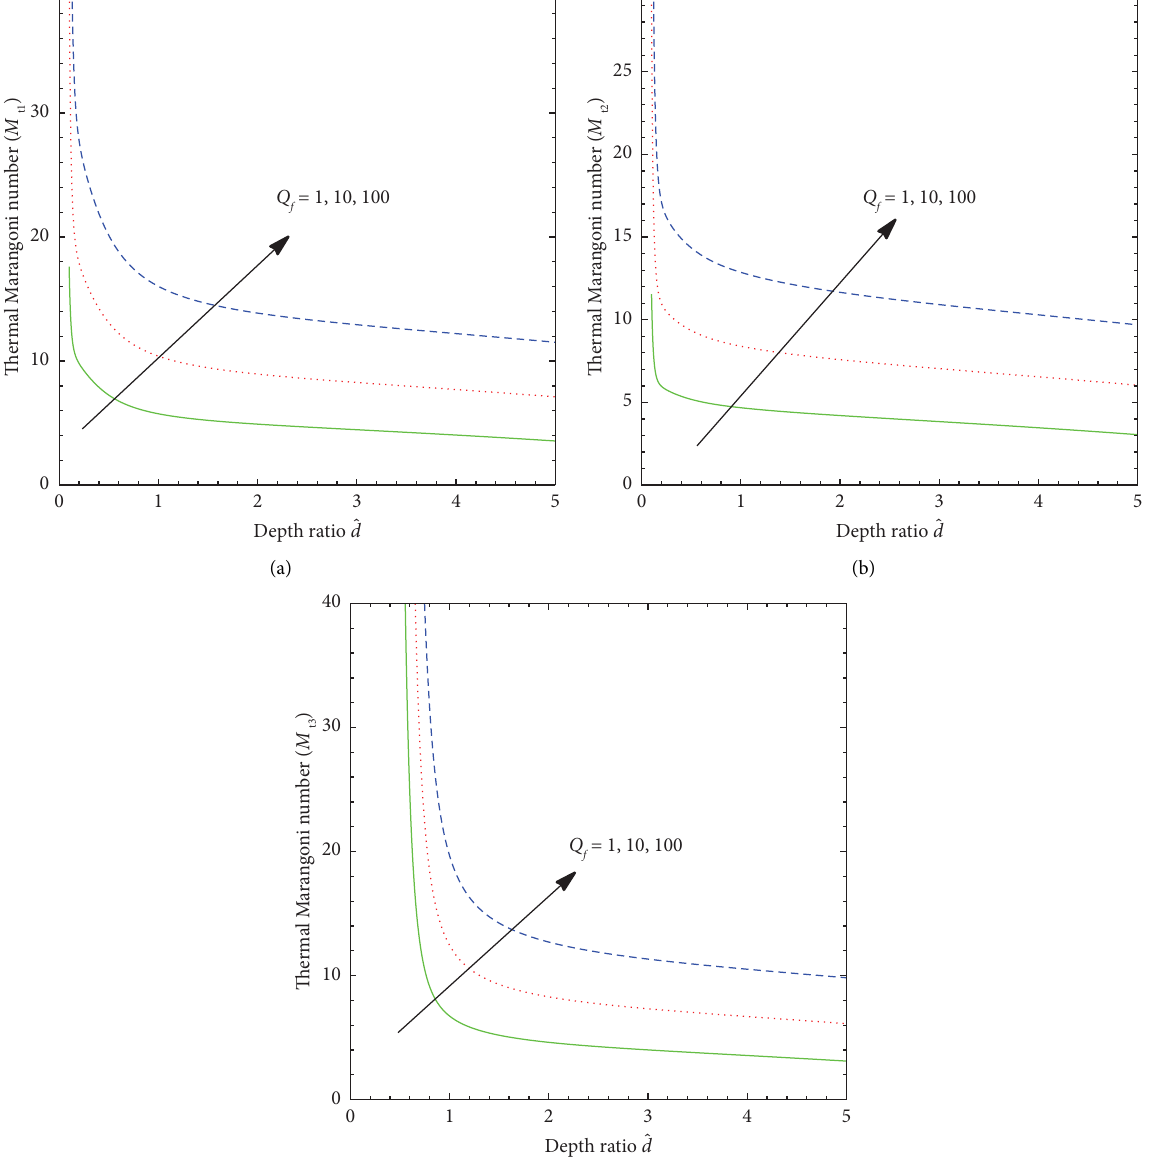
� 1 , 10 , 100 when a f